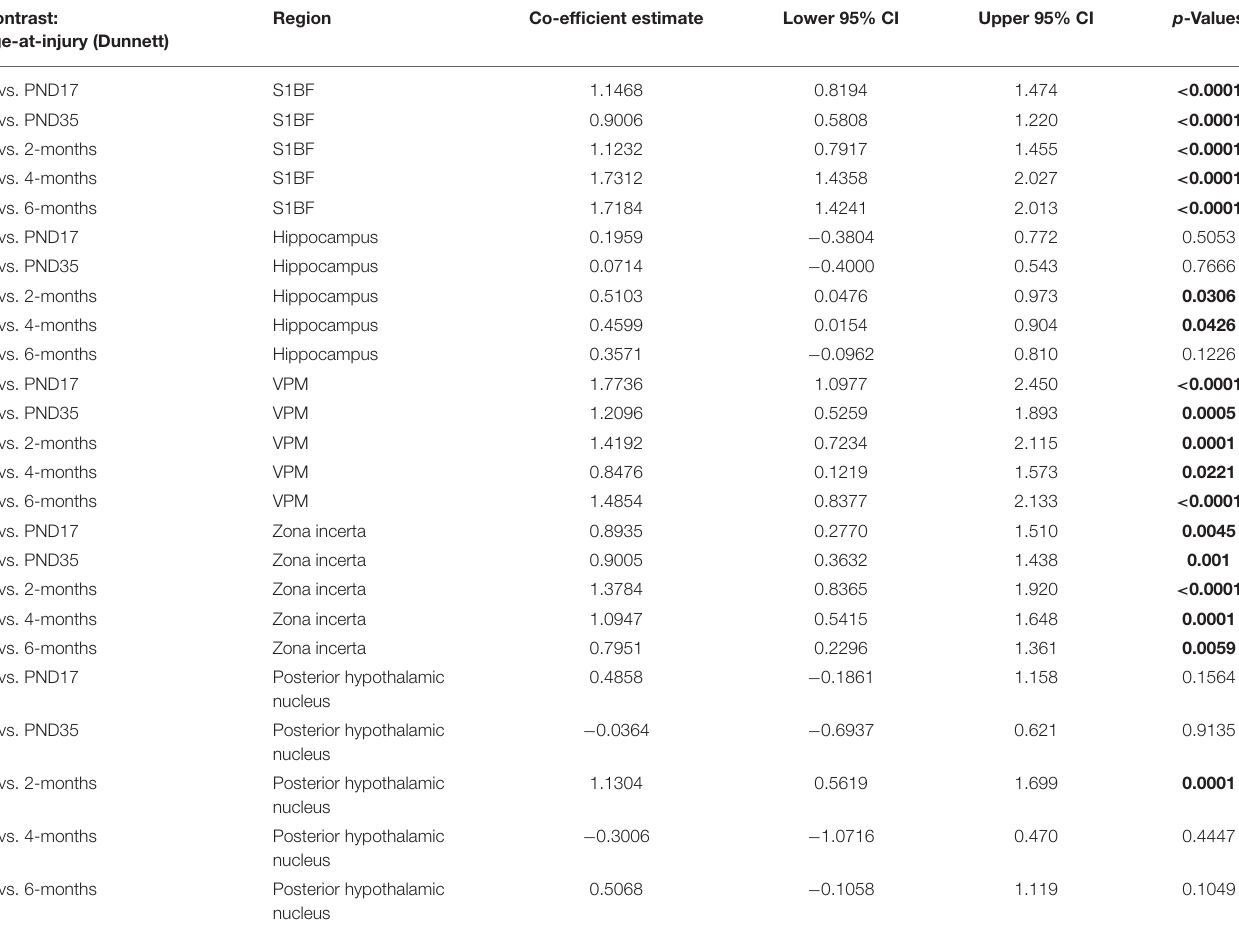
TABLE 5 | CD68-positive microglia post-hoc contrasts between age-at-injury groups and naïve controls, separated by region, using the Dunnett’s procedure. Contrast: age-at-injury